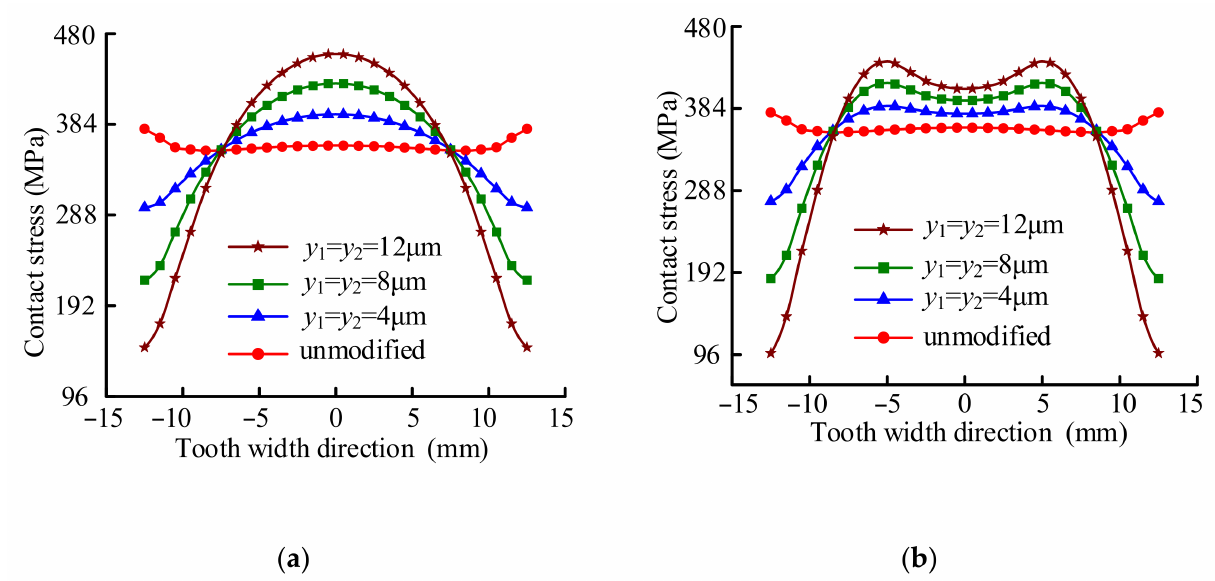
Figure 14. Tooth surface load distribution of the novel gears at the pitch circle position. ( a ) Parameter of tooth modification y 3 = 0; ( b ) Parameter of tooth modification y 3 = 8